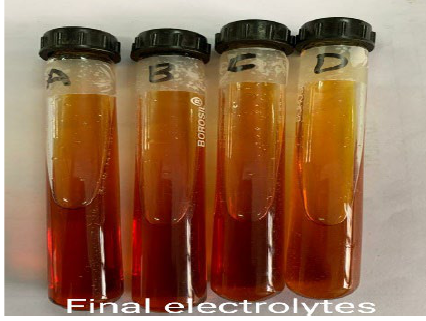
Figure 4. Quasi solid-state electrolyte